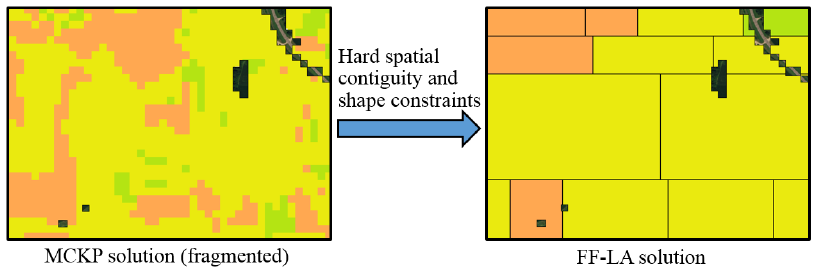
Figure 3. Fragmentation elimination with hard spatial